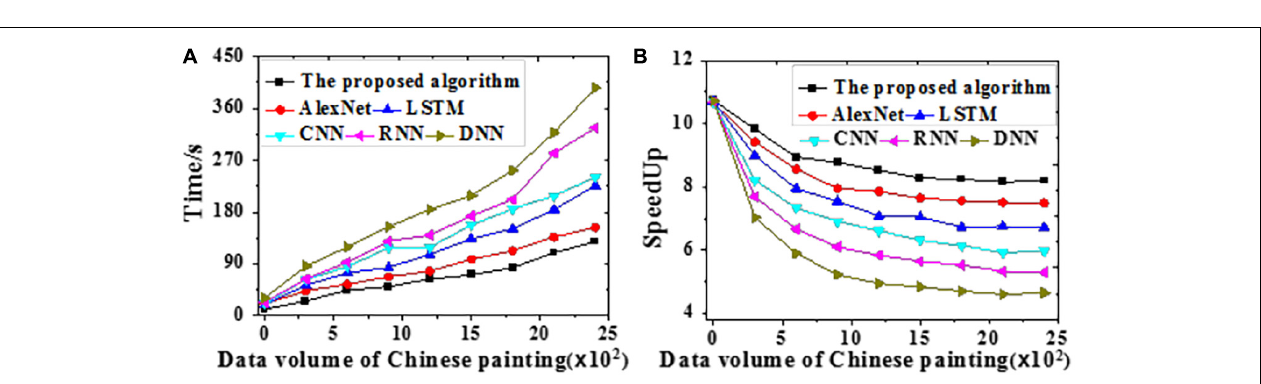
FIGURE 9 | The time required and speedup ratio of different models under different data volumes on the training dataset [ (A) Time required; (B) Speedup ratio].